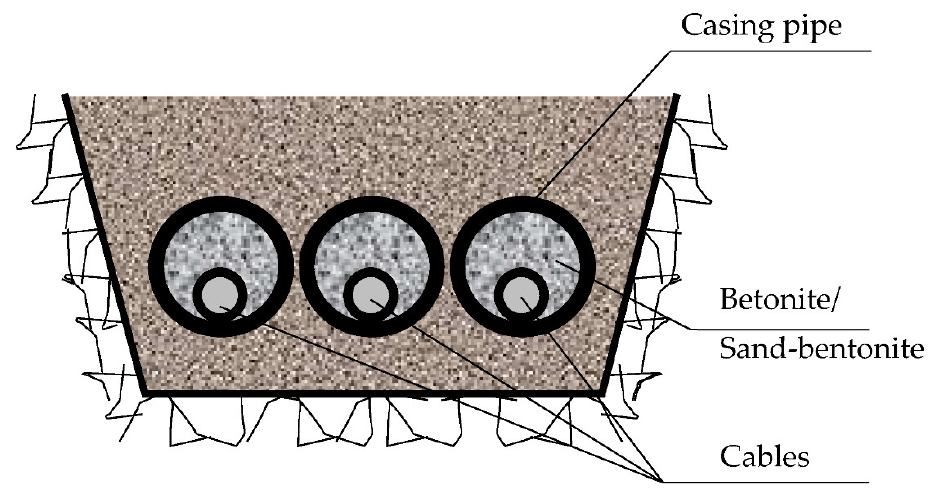
Figure 1. The cables in casing pipes buried in the trench.